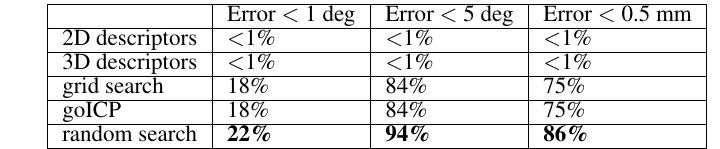
Table 1. Success rate in % of global registration. We measure the error using Equation 12 and 13. For grid search and random search, we perform the same number of trial (hundred of trials). GoICP has the same results as grid search if we limit the number of iterations for